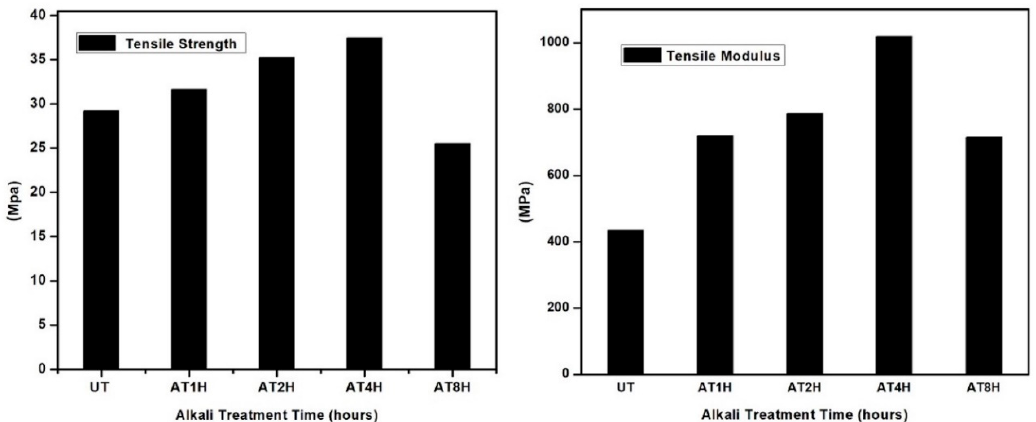
Figure 3. Tensile strength and Modulus of treated and untreated Typha fiber reinforced epoxy